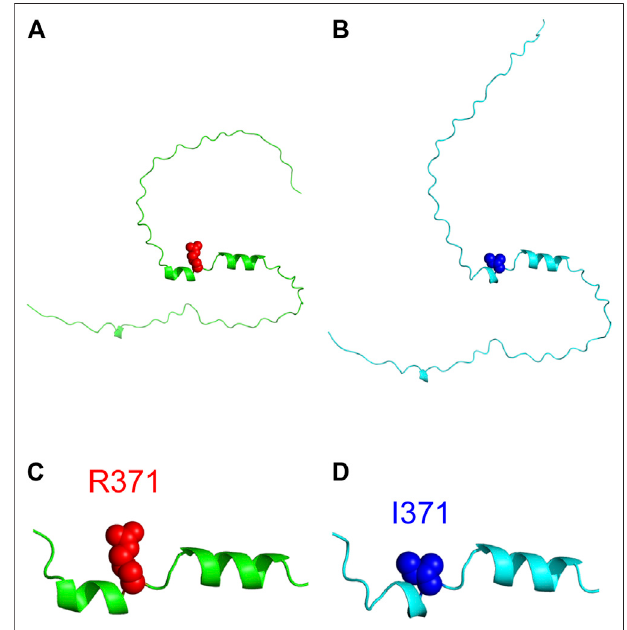
FIGURE 8 | Structure modeling of Int8. (A,B) Overall structures of the wild type (A) and R371I mutant (B) of Int8 predicted by AlphaFold2. (C,D) Expanded views of the helical regions of the wild type (C) and R371I mutant (D) . R371 and I371 are shown by red and blue balls, respectively. The Figures were drawn using the PyMOL Molecular Graphics System, Version 2.4.0 Schrödinger, (~100 μ M), weight at the elution peak was of 11.3 (±0.6) kDa, which is close to the value for an Int8 monomer ( Supplementary Figure S3 ). However, the mutant started to elute earlier than the wild type, indicating the presence of slight determined by the PFG NMR measurements at 150 μ M may correspond to the molecular size of these aggregates. Taken together, these results clearly demonstrate that the R371I mutant of Int8 is prone to aggregation.